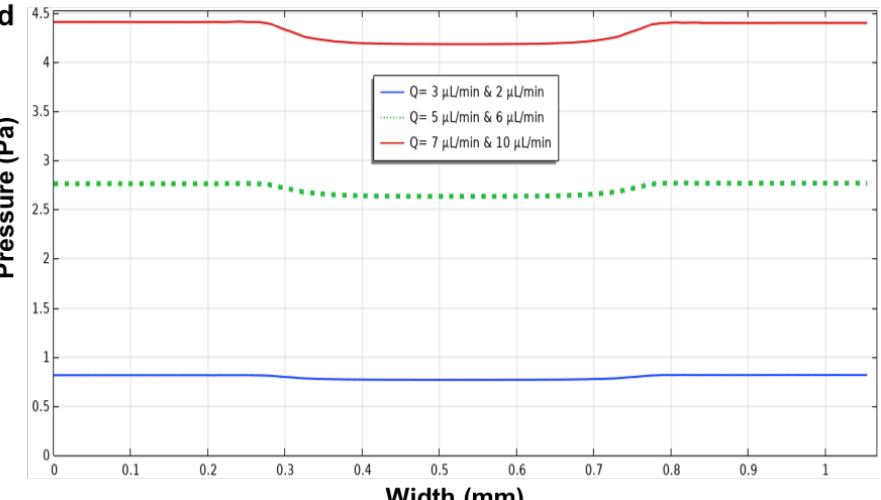
Figure 9. The velocity, wall shear stress (at h = 0 µm, the bottom) and in the middle (h = 100 µm) of the microchannel, and pressure profiles using six flow rates within the side and main microchannels versus the width of the microchannel. ( a ) the velocity magnitude; ( b ) wall shear stress at h = 0 µm and; ( c ) at h = 100 µm; ( d ) pressure using flow rates of 3 µL/min (main microchannel) and 2 µL/min (side microchannels) (blue line); 5µL/min (main microchannel) and 6 µL/min (side microchannels) (dotted green line); and 7 µL/min (main microchannel) and 10 µL/min (side microchannels) (red line). Red circles highlight the velocity and shear stress fluctuations near the micropillar structures.